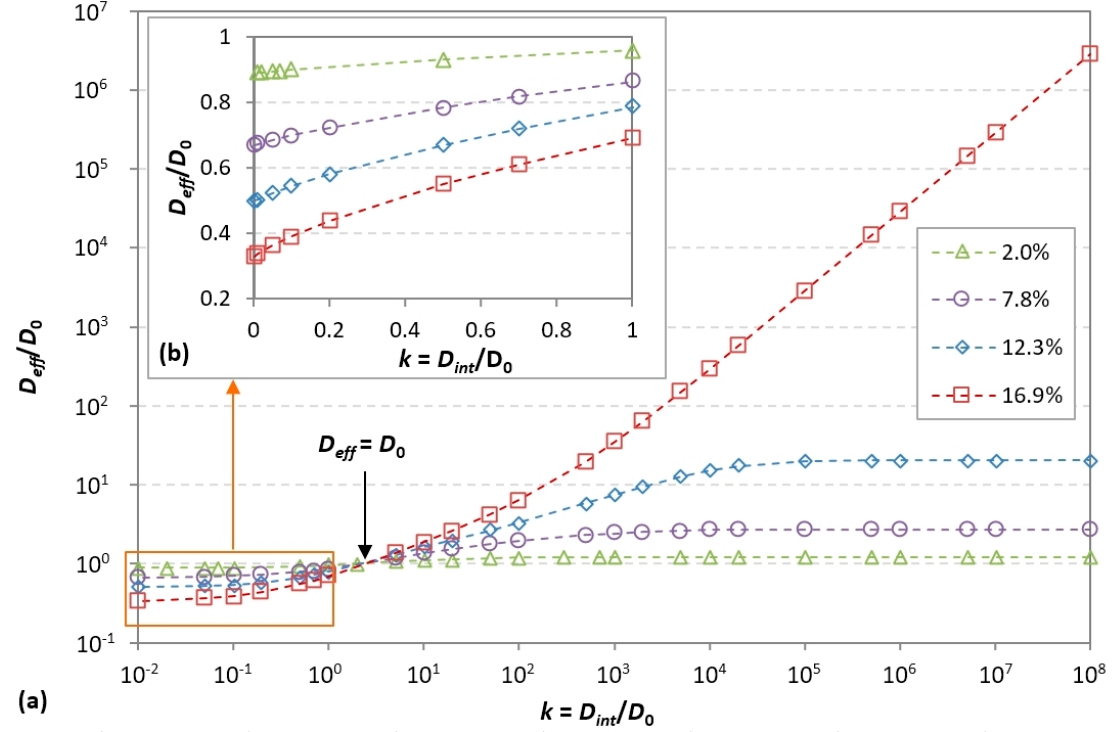
Figure 11. Effects of filler–matrix interphase diffusivity on the nanocomposite’s relative effective diffusivity for several filler volume fractions (2 %, 7.8 %, 12.3 % and 16.9 %), with an interphase thickness e int = 10 nm: ( a ) full D int range (log scale); ( b ) D int < D 0 (linear scale).